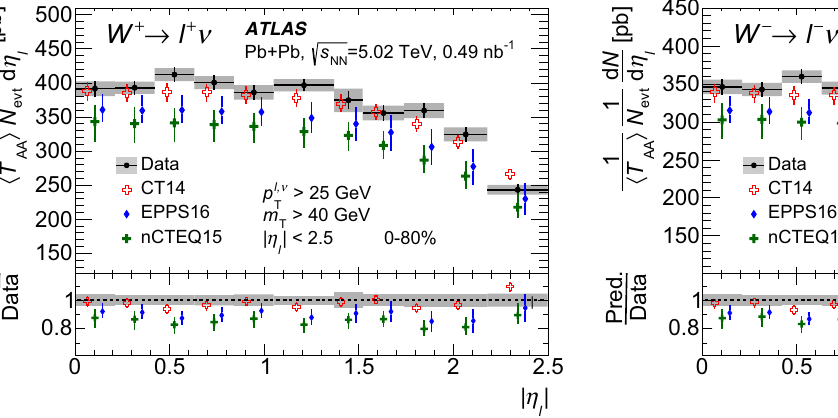
Fig. 10 Differential normalised production yields for W + (left) and W − (right) bosons as a function of absolute pseudorapidity of the charged lepton for the combined electron and muon channels. Error bars show statistical uncertainties, whereas systematic uncertainties are shown as shaded boxes. Systematic uncertainties related to (cid:4) T AA (cid:5) are not included. The measured distributions are compared with theory pre- dictionscalculatedwiththe CT14 NLO PDFsetaswellaswithEPPS16